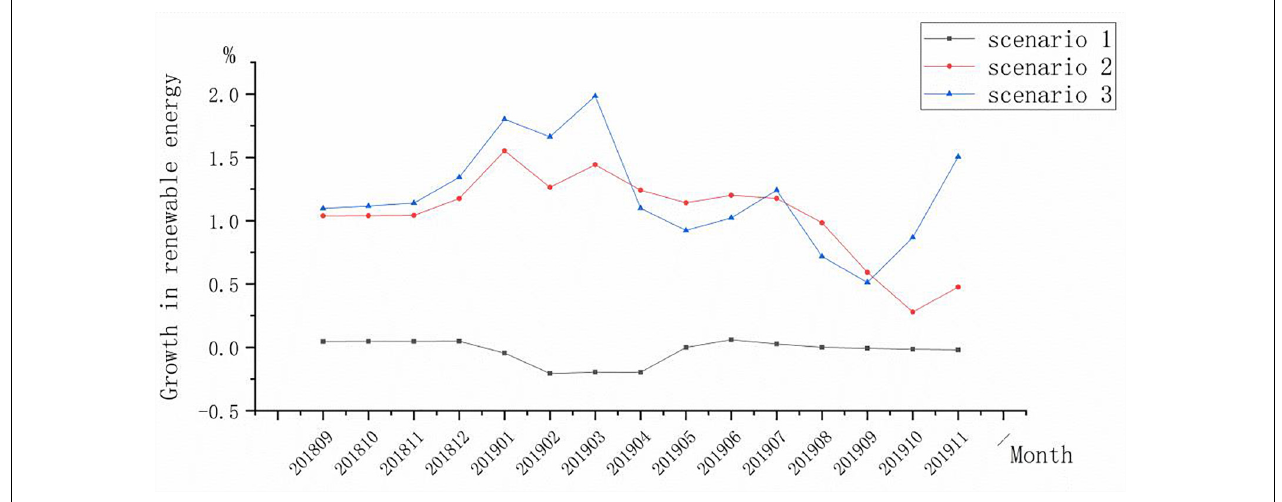
FIGURE 5 | The growth rate of renewable energy supply in each scenario. TABLE 3 | Production and reserve of seven metals. Material Dy Nd Te In Ga Cd Se